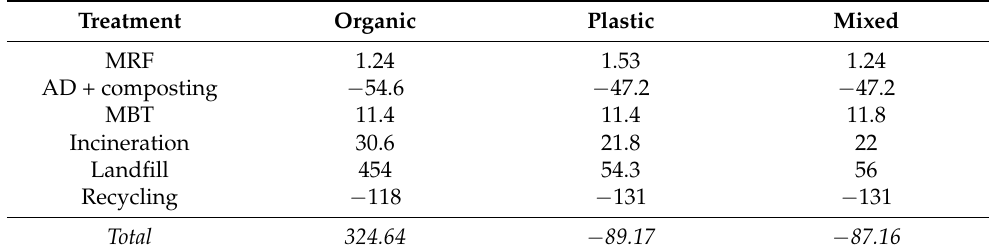
Figure 3. Contribution of each process in the economic assessment of organic, plastic and mixed waste treatment routes. Table 4. Carbon footprint (CF) in terms of kgCO 2 -Eq. of the whole waste management system and for each treatment for organic, plastic and mixed waste treatment